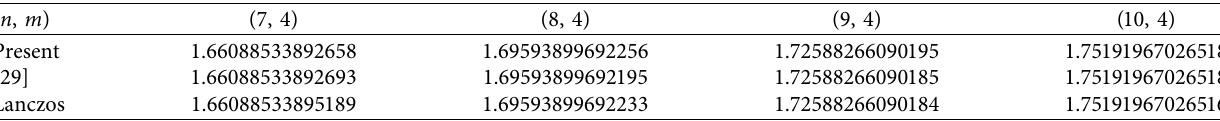
Figure 3: For Example 3, (a) showing one root of the nonlinear equation obtained from the new quotient, corresponding to the eigenvalue 1.56705069109793, and (b) obtained from the Rayleigh quotient giving no root in the interval which is incorrect. Table 2: Te largest eigenvalues of the Hilbert matrices with n � 7, 8, 9, and